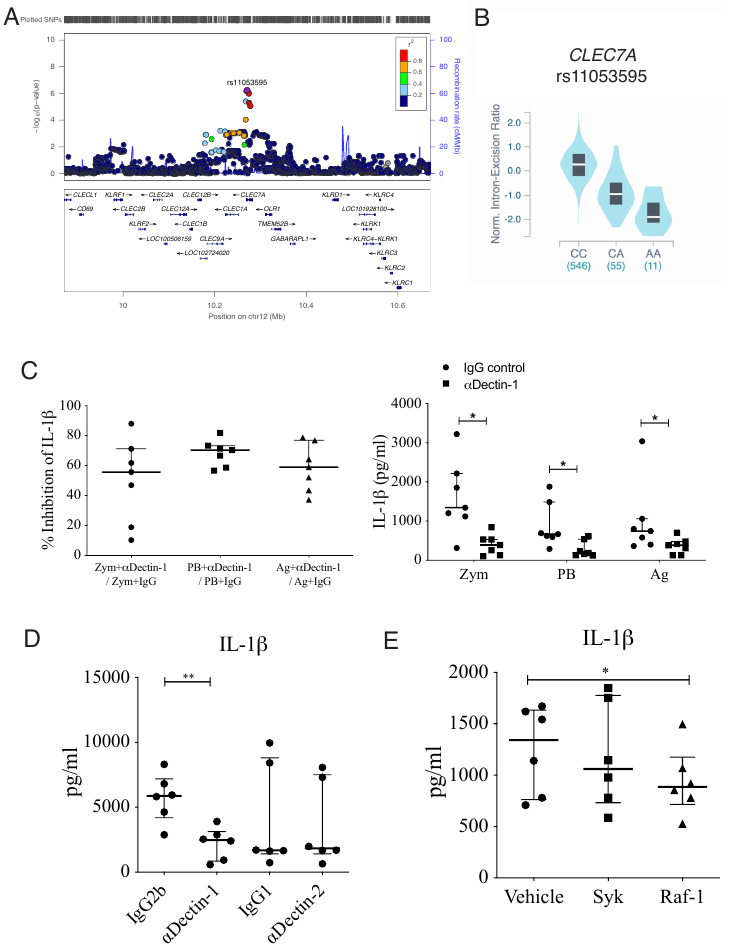
Figure 3. Regional association plot for IL-1 β QTL and relevance of Dectin-1 for IL-1 β induced by Paracoccidioides brasililensis . ( A ) The regional association plot for the IL-1 β production-associated SNP (rs11053595, purple diamond), which is located in the 3 (cid:48) UTR region of the CLEC7A gene at chromosome 12. Each dot represents an SNP, and the linkage disequilibrium of neighboring SNPs with the top SNP is color-indicated. The y -axis represents − log10 p values of SNPs. The x -axis shows chromosome 12 positions. ( B ) Whole blood GTEX expression data obtained from individuals carrying different genotypes of the rs11053595 SNP (www.gtexportal.org (accessed on 24 March 2023)). ( C ) Inhibition of IL-1 β by neutralizing Dectin-1 antibodies for each stimulus. PBMCs (2.5 × 10 5 cells/well) obtained from healthy donors were incubated in the absence or presence of neutralizing anti-Dectin-1 antibodies ( α Dectin-1 at 10 µ g/mL) or control IgG antibodies (IgG at 10 µ g/mL) for 1 h. After, the cells were stimulated with 50 µ g/mL of Zymosan (Zym), 1 × 10 6 yeasts/mL (2.5 PBMCs:1 yeast) of heat-killed yeasts P. brasiliensis (PB), or 20 µ g/mL of particulate antigens from P. brasiliensis yeasts (Ag) for 24 h. The supernatant was collected to measure the amount of IL-1 β by ELISA. (n = 7). On the left, results showed the inhibition of IL-1 β production (stimulus + α Dectin-1) in relation to the IgG antibody control (stimulus + IgG); on the right are shown the absolute values of IL-1 β concentration after Dectin-1 blocking. ( D , E ) PBMCs (2.5 × 10 5 cells/well) obtained from healthy donors were incubated in the absence or presence of neutralizing anti-Dectin antibodies ( α Dectin-1and α Dectin-2 at 10 µ g/mL) or isotype control antibodies (IgG2b and IgG1 at 10 µ g/mL), 1 µ M of Raf-1, 50 nM of Syk inhibitor or vehicle for 1 h. Cells were stimulated with heat-killed yeasts of P. brasiliensis (2.5 PBMCs:1 yeast) for 24 h and IL1 β production was assessed in the supernatant by ELISA. (n = 6). The data are presented as individual values and medians and interquartile ranges (Wilcoxon paired test, * p < 0.05, ** p <